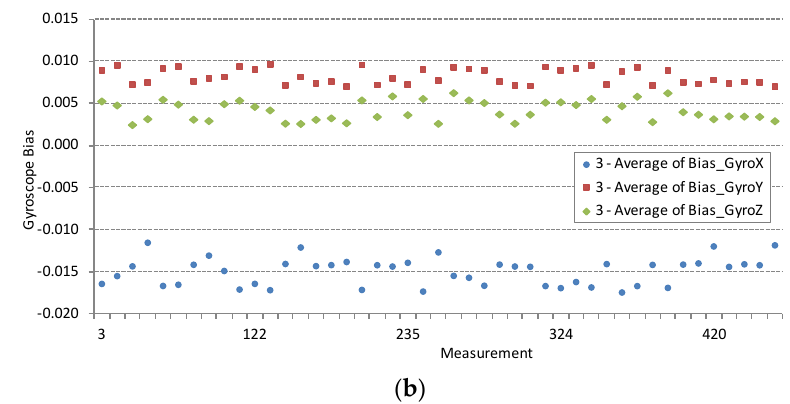
Figure 7. Repetitive accelerometer and gyroscope bias measurements ( N = 44) of the smartphone with ID = 3 showing bias variation. Measurement numbers are taken from the database and are not successive as other measurements took place in between two measurements of the presented device.